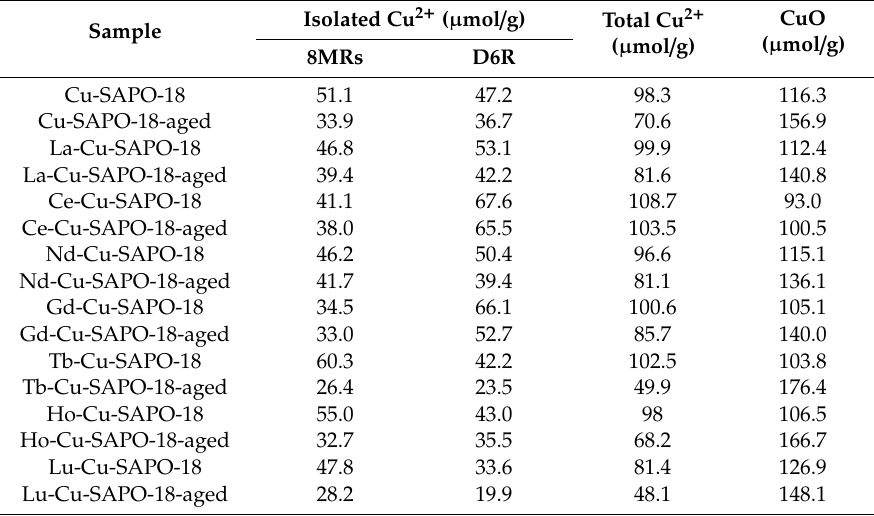
Table 3. Quantitative Analysis on the H 2 -TPR Profiles of the